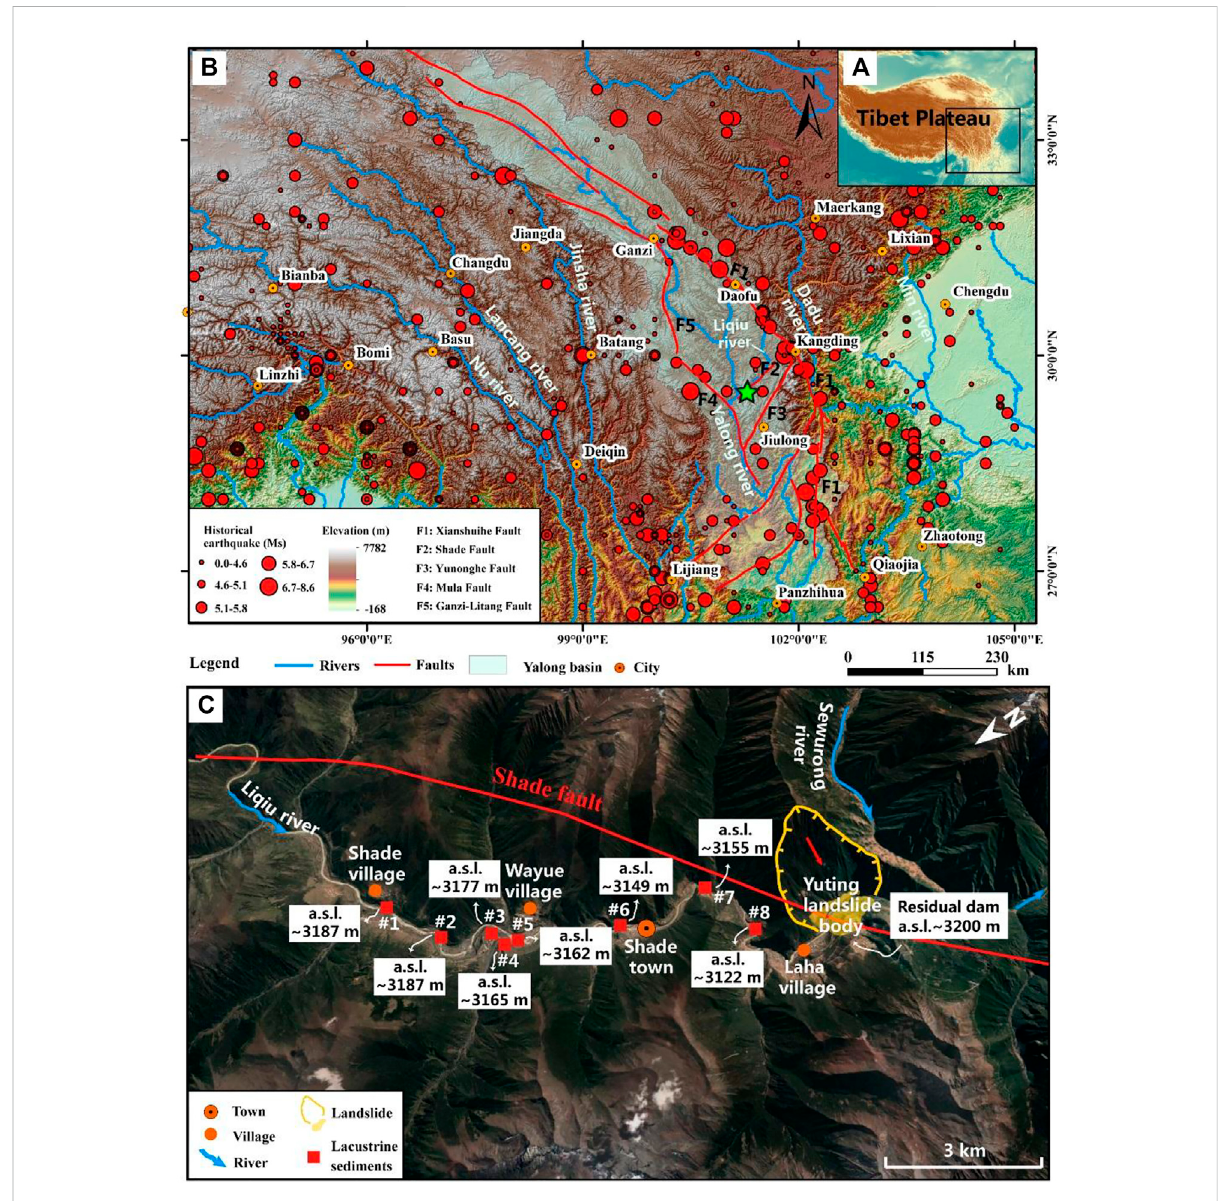
FIGURE 1 StudyareaandYutinglandslide-dammedlake. (A) MapoftheTibetanPlateau. (B) LocationofthestudyareaintheeasternTibetanPlateau.Filled red circles represent historical earthquakes. The green pentagram in (A) represents the location of the Yuting landslide-dammed lake. (C) Satellite image of the Yuting landslide-dammed lake. Satellite image is from Google